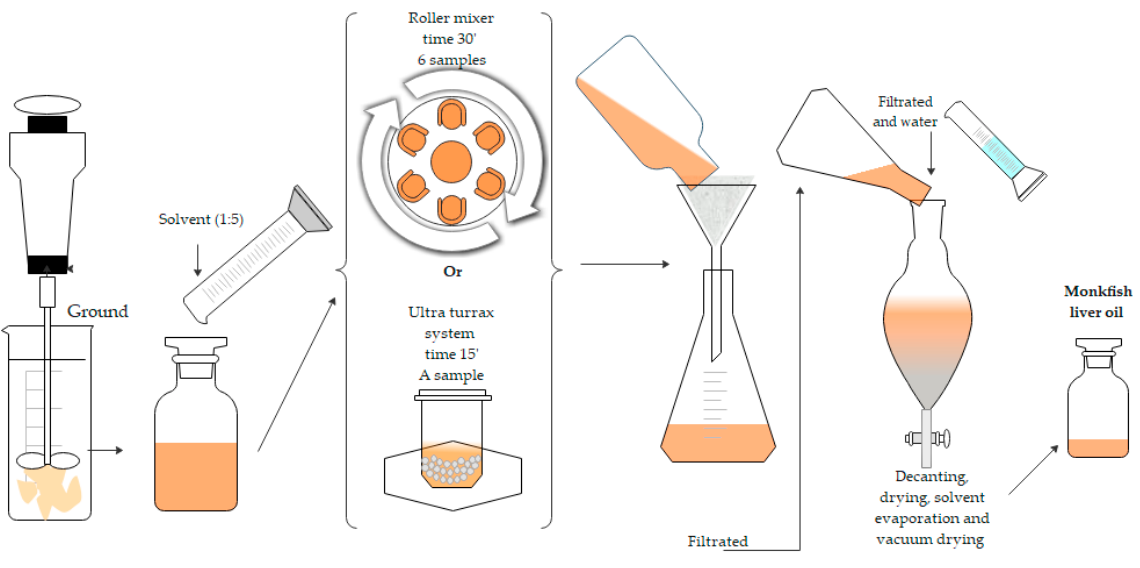
Scheme 1. General procedure to the extraction of monkfish liver oil using two systems; Roller Mixer (RM) and ULTRA- TURRAX® (UT).